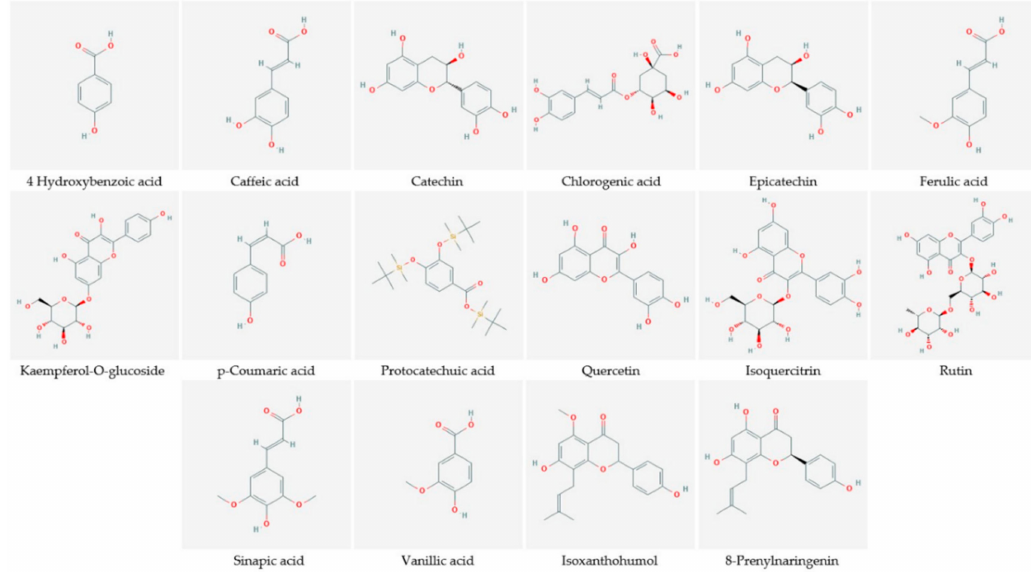
Figure 1. Some of the phenolic compounds of regular beers and nonalcoholic beers (NABs)